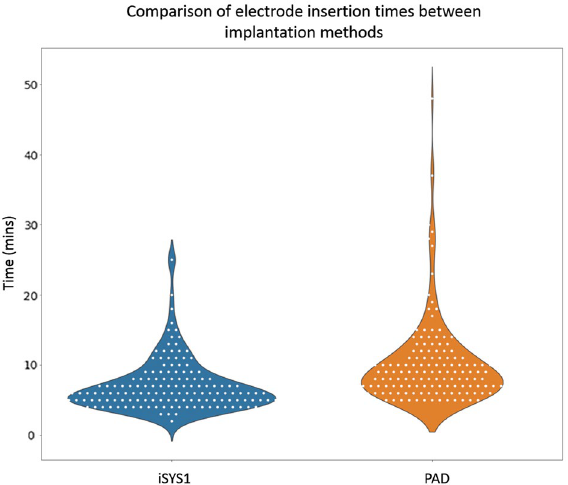
Figure 2. Combined violin and swarm plot demonstrating individual electrode insertion times (white dots) between the iSYS1 (blue) and PAD (orange) insertion techniques. The width of the violin plots correspond to the number of electrode insertions at each time